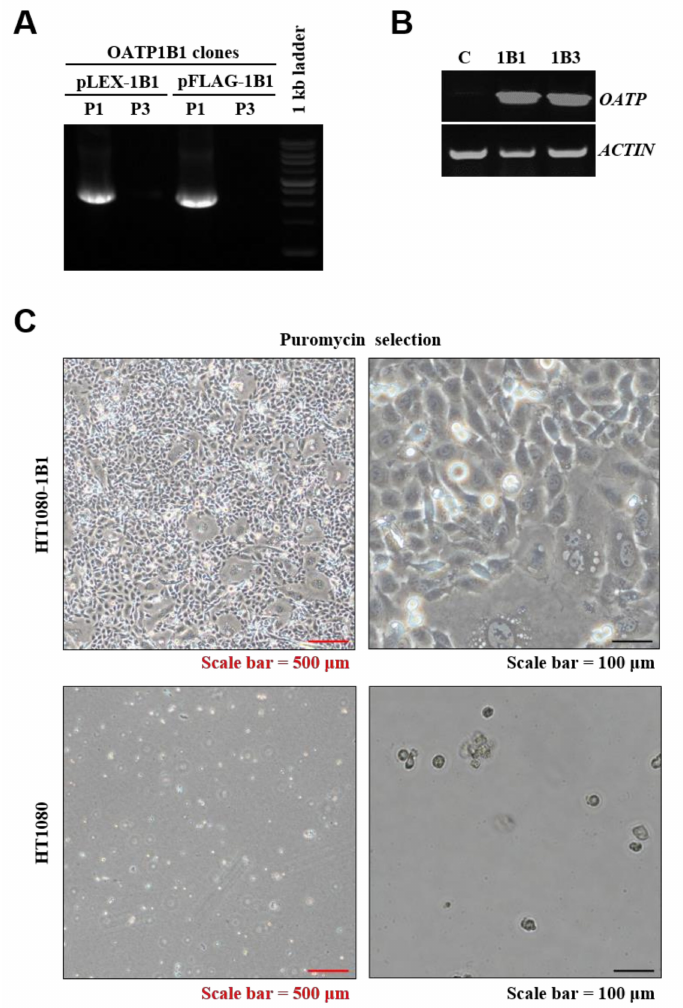
Figure 3. Validation of OATP1B1 construction and stable-expressing cell line. ( A ) PCR showing insert fragments of OATP1B1 (2037 bp). ( B ) RT-PCR revealing the mRNA expression level of OATP1B1- and OATP1B3-expressing cells. ( C ) Morphology of OATP1B3-expressing HT1080 and untransduced HT1080 under 2 µ g/mL puromycin selection. P1, OATP1B1-specific primer; P3, OATP1B3-specific primer; C, control; 1B1, OATP1B1-expressing cells; 1B3, OATP1B3-expressing